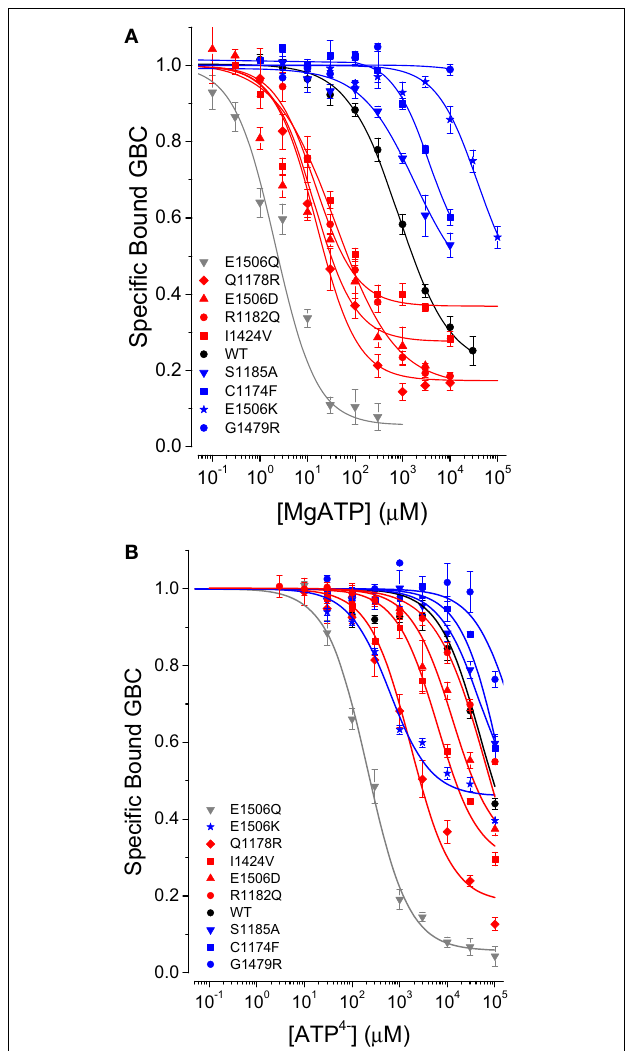
FIGURE 3 | Comparison of nucleotide-induced conformational switching inWT and SUR1 mutants . (A) MgATP. (B) ATP 4 − + 0.1mM